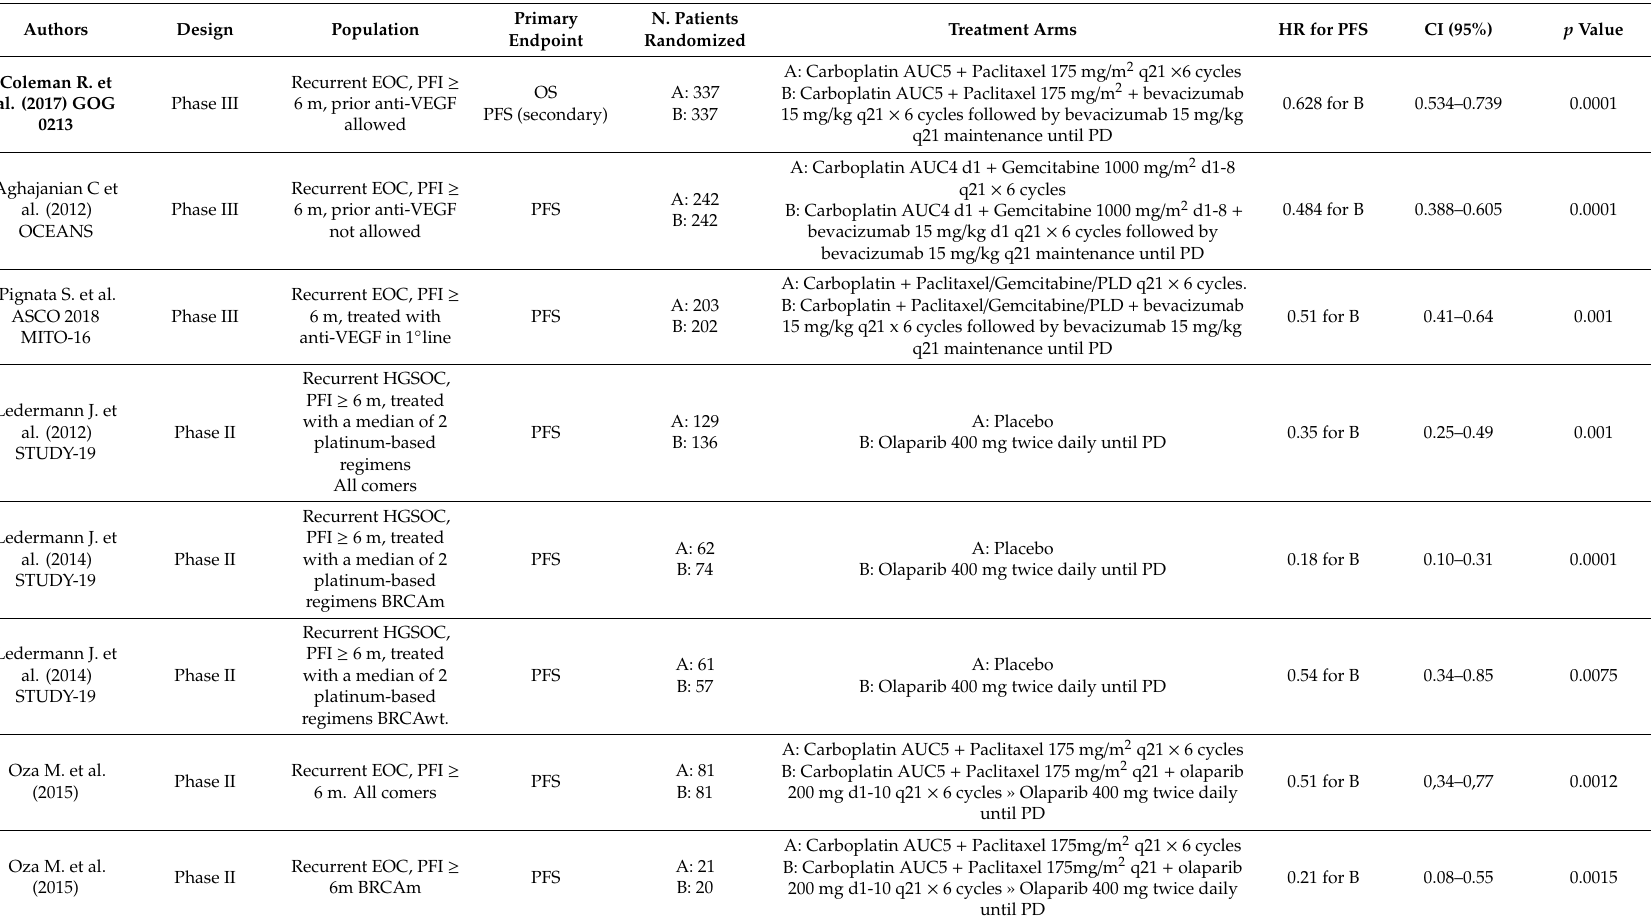
Table 1. Studies included in the network meta-analysis. Data on all comers (AC), BRCA mutated (BRCAm), and BRCA wild type (BRCAwt) subgroups are reported, arranged in di ff erent